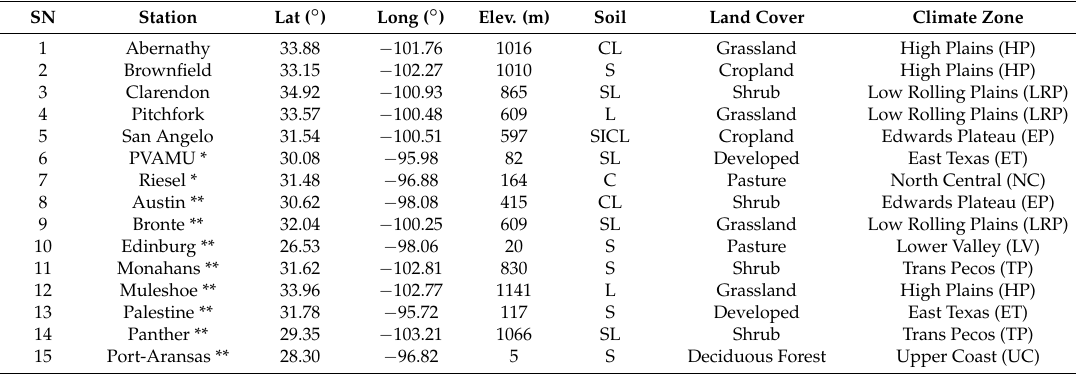
Table 2. West-Texas Mesonet, U.S. Climate Reference Network (USCRN) and Natural Resources Conservation Service (NRCS) Soil Climate Analysis Network (SCAN) stations used in this study. SN Station Lat ( ◦